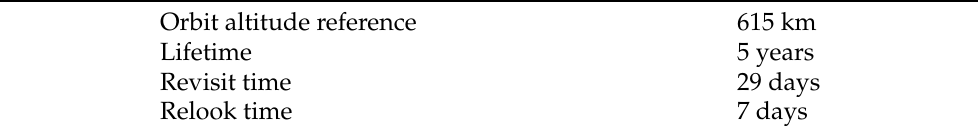
Table 1. Main PRISMA mission